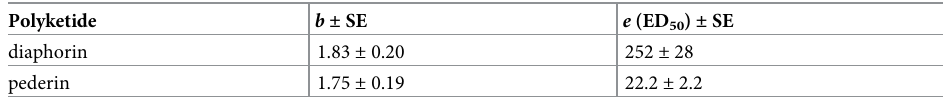
Table 2. Coefficients of the model fitted to the polyketide dose–BY4741 growth response